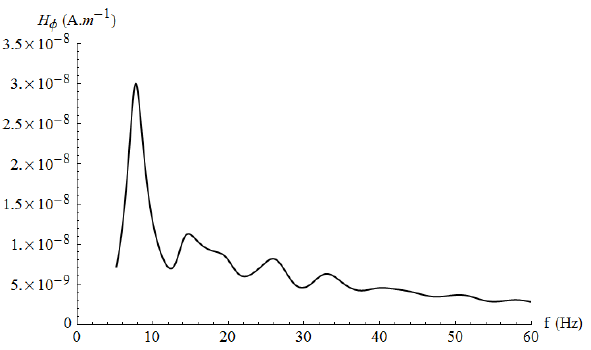
Figure 8: Magnetic field versus frequency at a distance of 5000 km from the source.